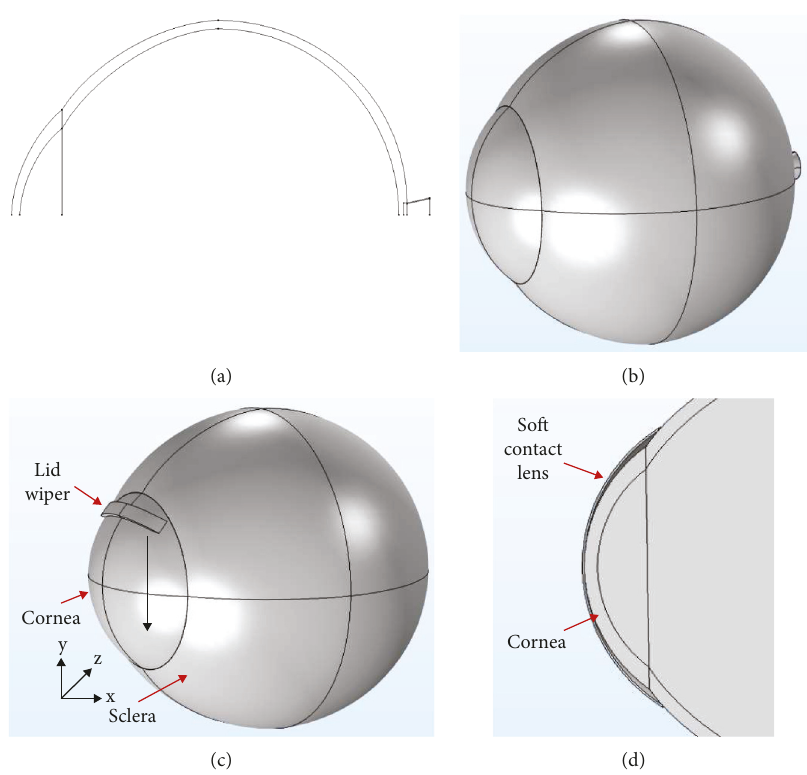
Figure 1: Two-dimensional (a) and three-dimensional model of the eyeball (b). Three-dimensional model of the eyeball with lid wiper (black arrow represents the direction of movement of the lid wiper on the cornea) (c). Cross section of the eyeball with soft contact lens (d). The model was constructed using COMSOL Multiphysics v5.2 (https://www.comsol.com) and the collage of the exported images was made